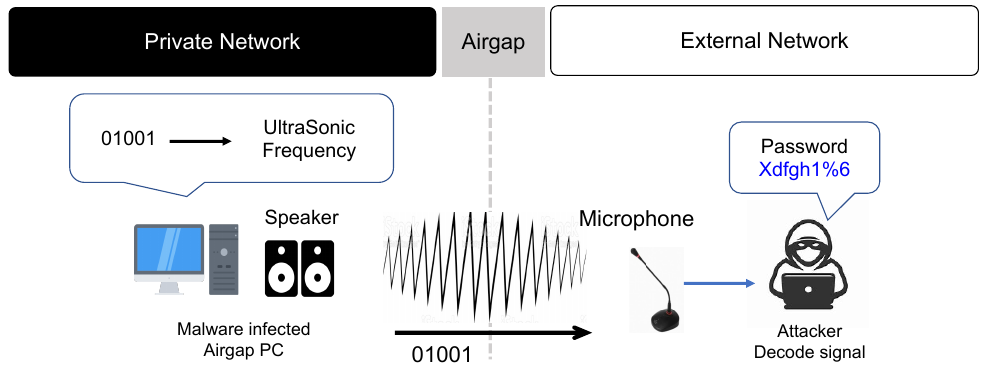
Figure 12. Conceptual diagram of air-gap attack using PC speaker sound